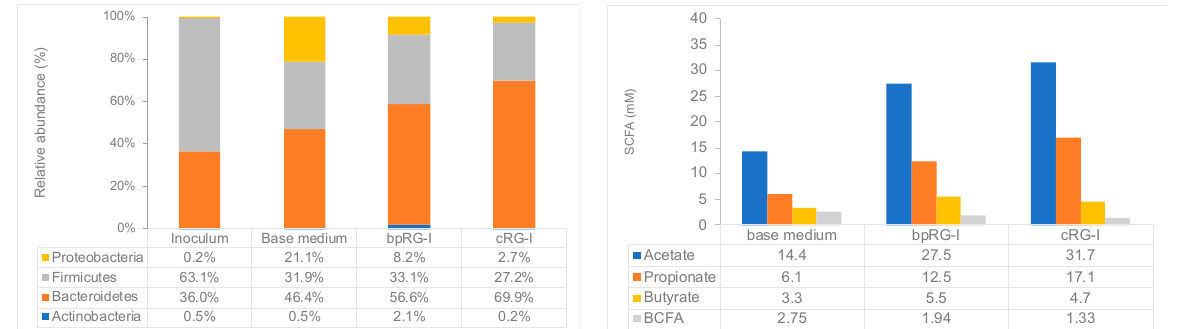
Figure 5. Left , effect on microbiota community composition at phylum level (expressed as relative abundance). Right , levels of branched-chain fatty acids (BCFA) resulting from protein fermentation were decreased in cultures containing bpRG-I or cRG-I. Globally, the results of these batch cultures show that bpRG-I and cRG-I are effectively fermented resulting in similar profiles of SCFA with cRG-I inducing a slightly stronger effect.